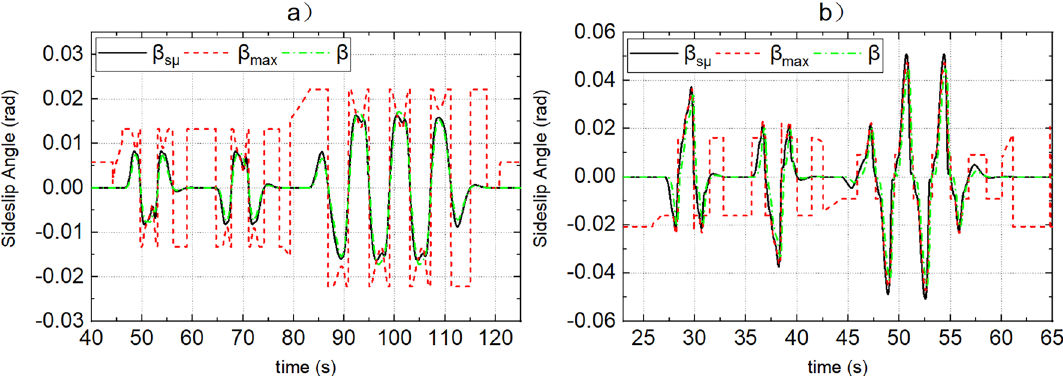
Figure 7. ( a , b ) Represent the response of sideslip angle of dynamic boundary and actual sideslip angle when the road adhesion coefficients are 0.15 and 0.8, respectively.